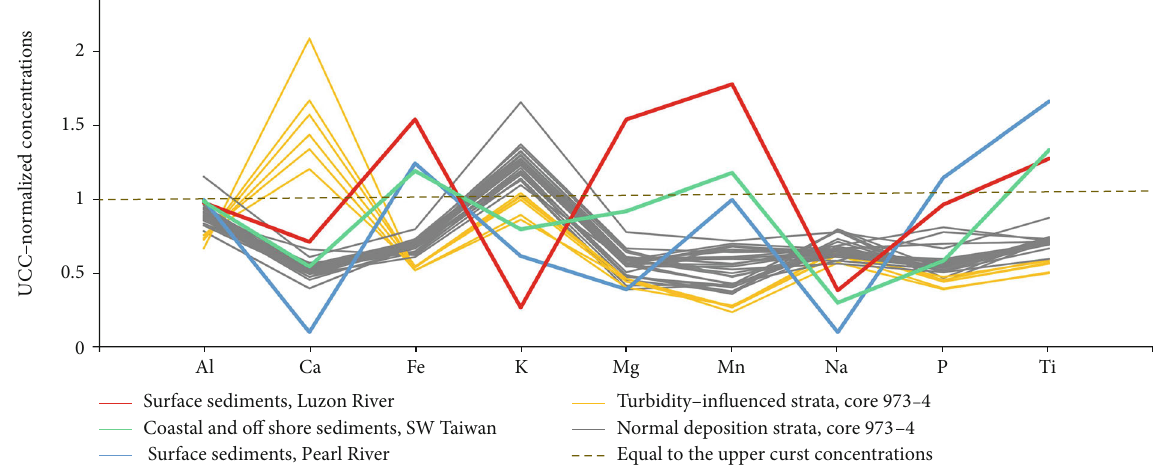
Figure 4: UCC-normalized major element concentrations at core 973-4 since the past 42 kyr, showing comparisons with those from the Pearl River [54], Luzon River [56], and o ff shore of SW Taiwan